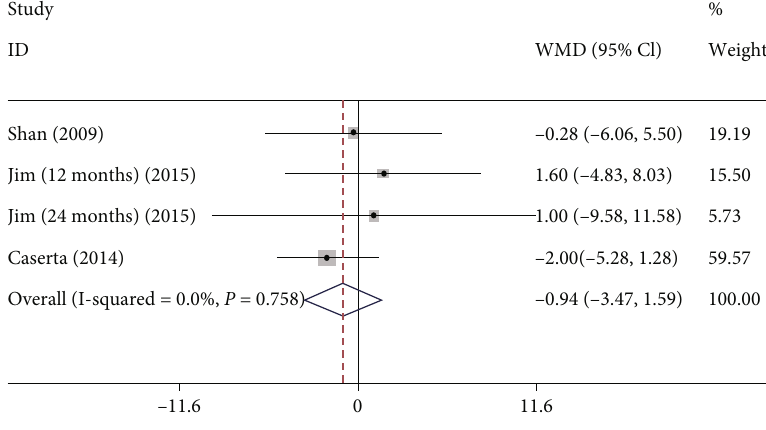
Figure 6: The forest plots of MDI between CMV and control groups.